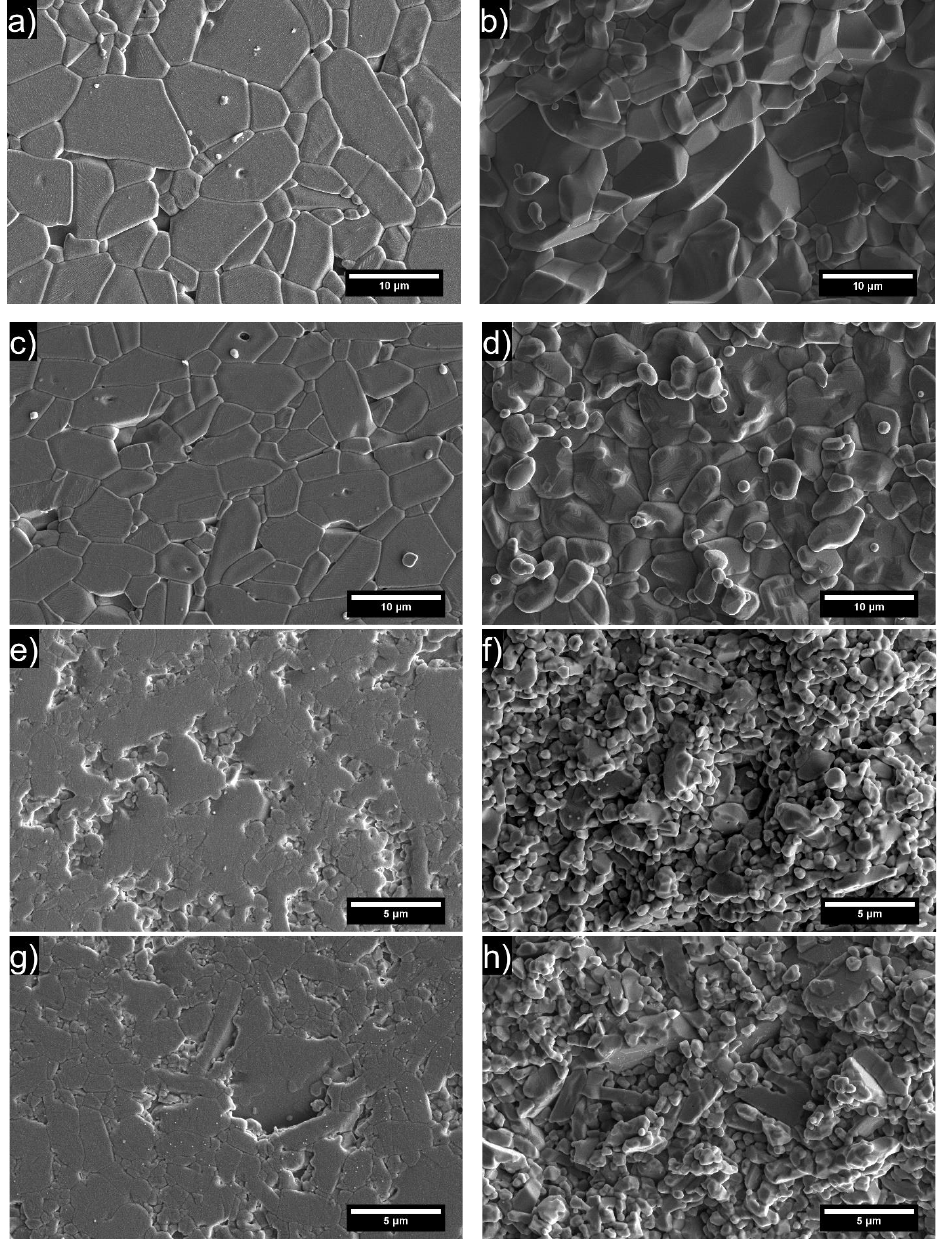
Figure 4. FESEM images of alumina surface microstructure. ( a ) OSS/0 dwb. % WAP; ( c ) OSS/20 dwb. % WAP; ( e ) TSS/0 dwb. % WAP; ( g ) TSS/20 dwb. % WAP and of respective sample fracture surface: ( b ) OSS/0 dwb. % WAP; ( d ) OSS/20 dwb. % WAP; ( f ) TSS/0 dwb. % WAP; ( h ) TSS/20 dwb. % WAP.